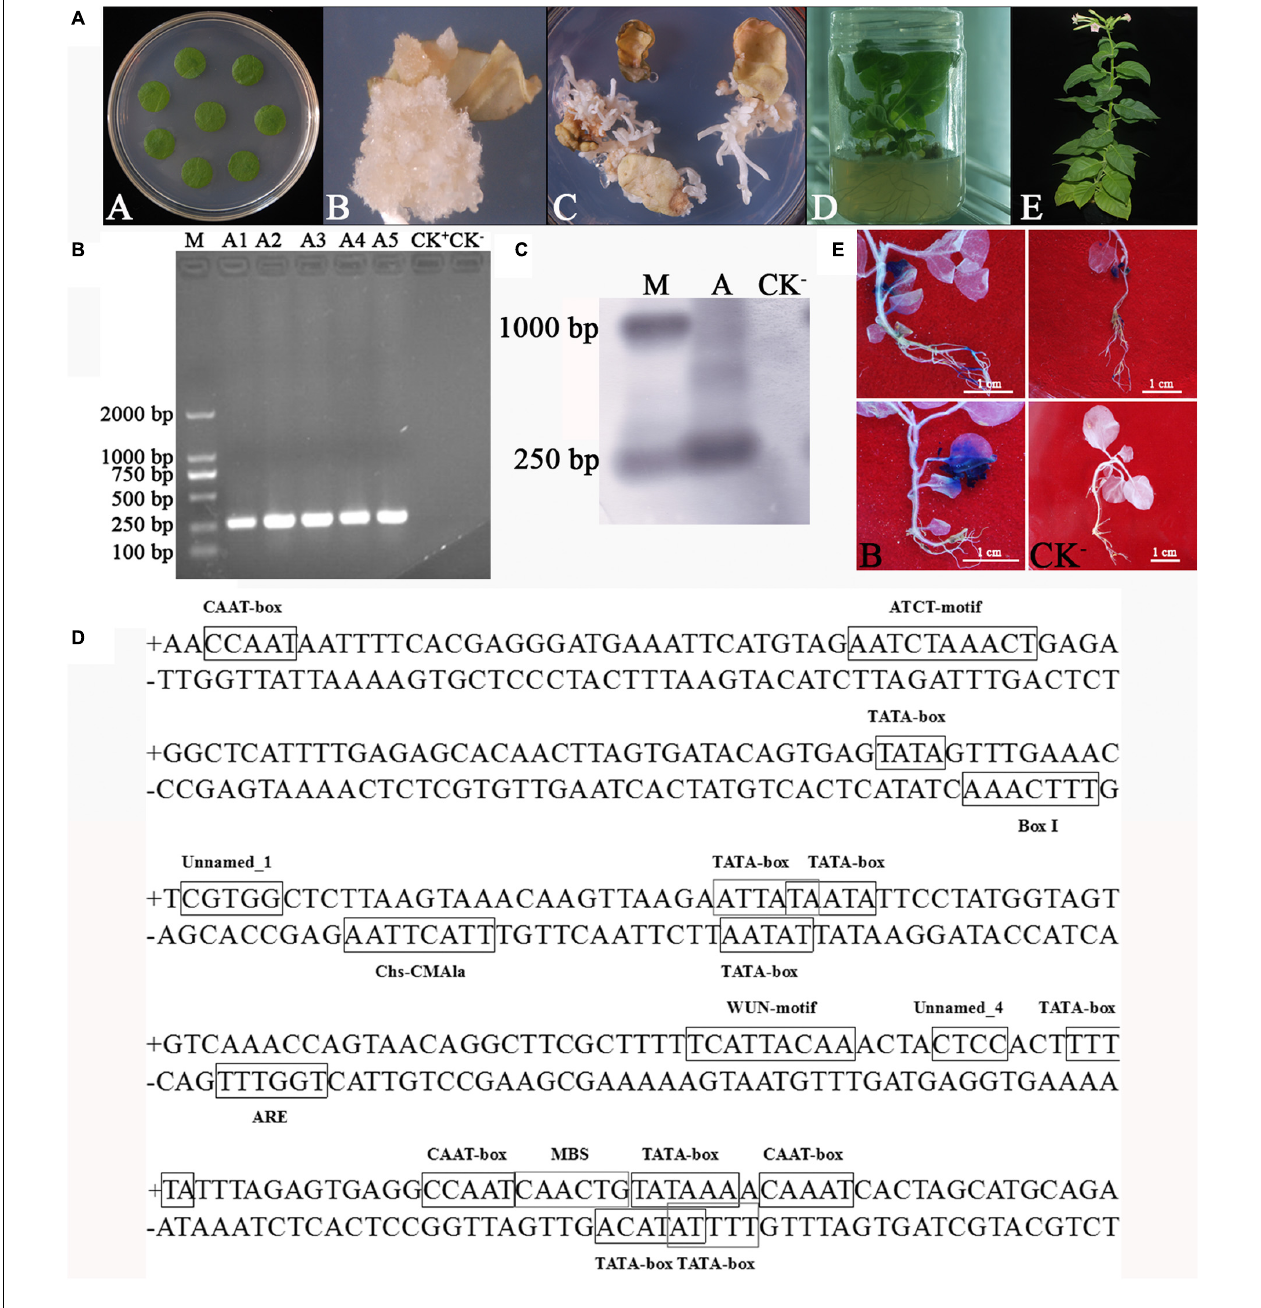
FIGURE 3 | Analysis of WY195 promoter type. (A) Stages of Agrobacterium -mediated tobacco transformation. (A) Tobacco leaf disks for co-cultivation with Agrobacterium inoculum. (B) Callus of N. tabacum . (C) Adventitious buds. (D) 14-day-old plantlets that survived on Kanamycin selection media transplanted to a jar. (E) Mature plants transplanted to soil. (B) PCR amplification. (M) Marker 2000; (A1)-(A5) WY195- GUS transgenic tobacco plants; (CK + ), pBI121 transgenic tobacco plants; (CK − ) N. tabacum wild type. (C) Southern blot analysis of WY195 in the genome of transgenic N. tabacum . (M) DNA molecular weight marker (DIG-labeled); (A) WY195 promoter; (CK − ) N. tabacum wild type. (D) Sequence analysis of predicted promoter WY195 by PlantCARE. (E) Histochemical staining for GUS activity in a T1 generation of WY195 transgenic tobacco grown under different conditions. (A) High temperature induced WY195- GUS transgenic tobacco; (B) Drought-induced WY195- GUS transgenic tobacco; (CK + ) 35S- GUS transgenic tobacco; (CK − ) N. tabacum wild type.